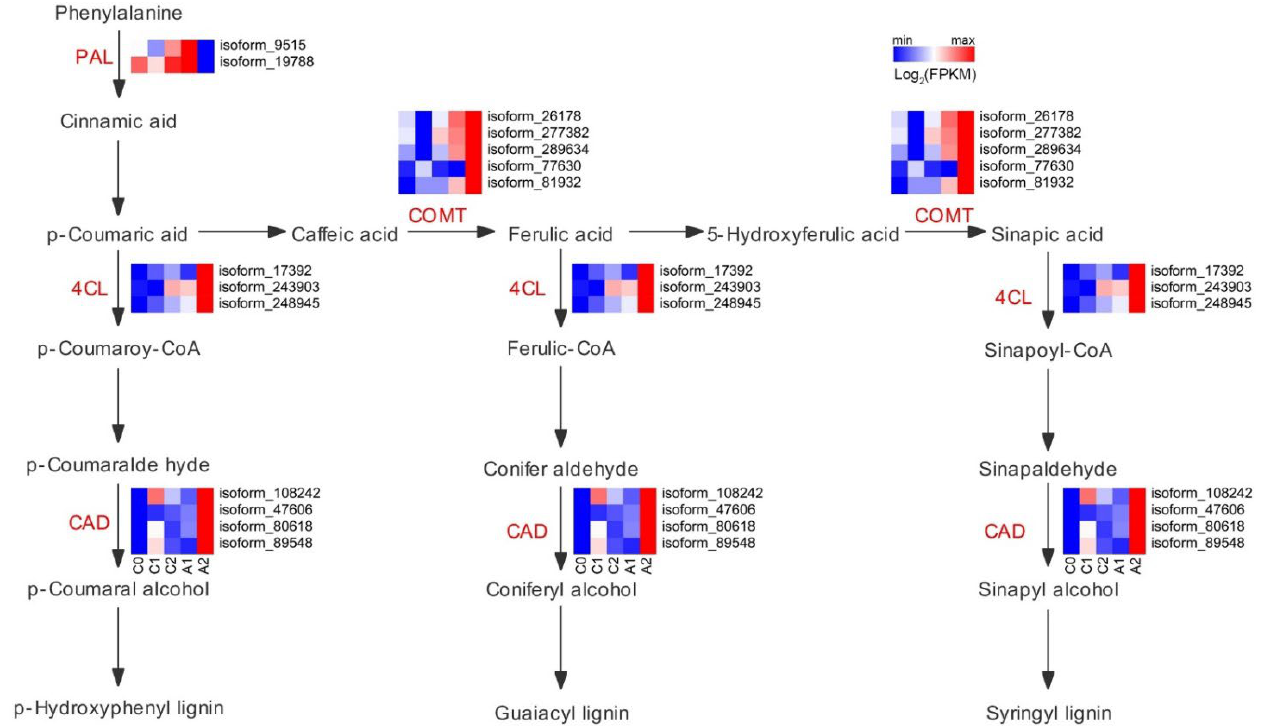
Figure 5. Expression of genes associated with phenylpropanoid biosynthesis. The colors scale ranging from green to red (row min to row max) indicates the expression of genes, and the expressions were presented as FPKM and normalized by log2.